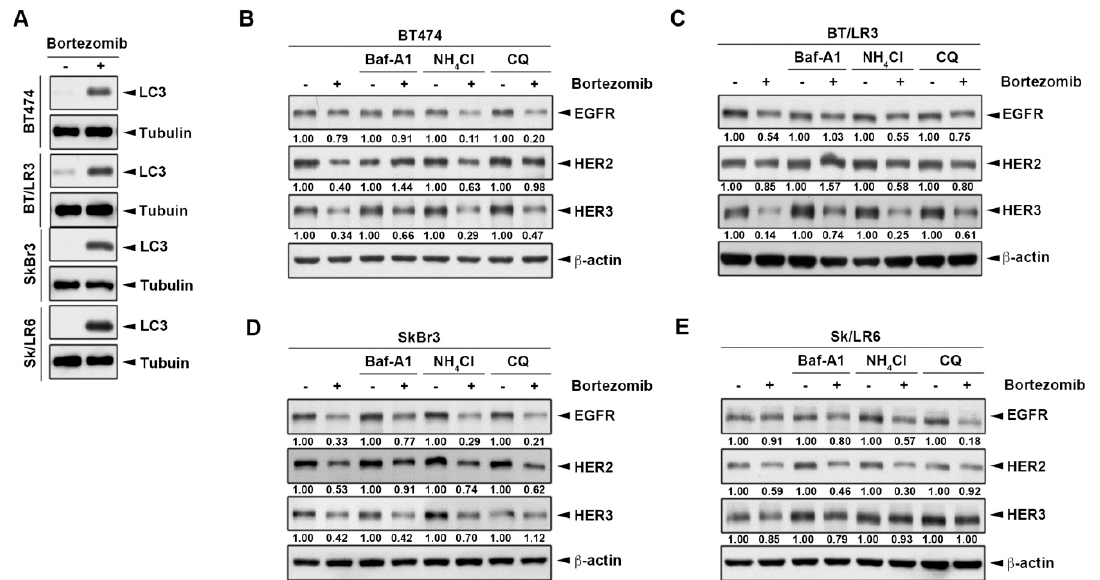
Figure 5. Bortezomib downregulated ErbB family expression via the lysosomal pathway. Cells were treated for three days with 50 nM bortezomib and whole cell lysates were subjected to western blot analysis to detect the autophagy marker LC3 expression ( A ). BT474 ( B ), BT / LR3 ( C ), SkBr3 ( D ), and Sk / LR6 ( E ) cells were co-treated with 50 nM bortezomib and lysosomal inhibitors 1 µ M Baf-A1, 10 mM NH 4 Cl, and 25 µ M chloroquine diphosphate (CQ). Whole cell lysates were subjected to western blot analysis with indicated antibodies. The intensity of bands in western blot was quantitated using image J and β -actin was used as the loading control for normalization.